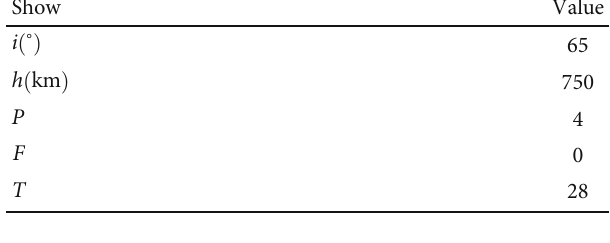
Figure 2: Brush lines of 9 satellites in COB ( h = 650km , i = 60 deg , ε > 10 deg ).